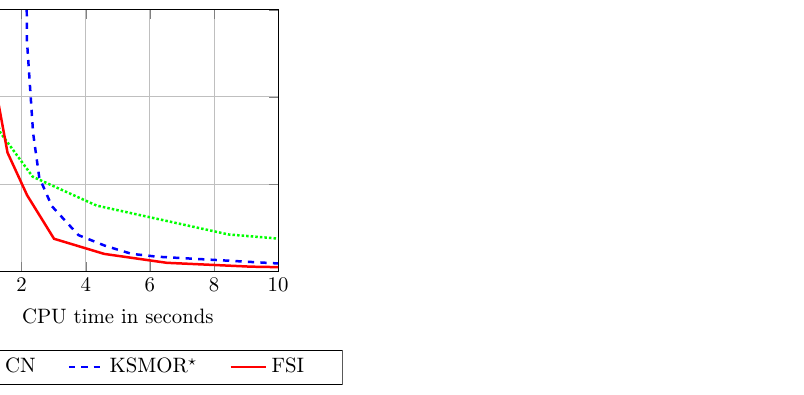
10 6 and h = 0.04 ( N = 100,701 ×